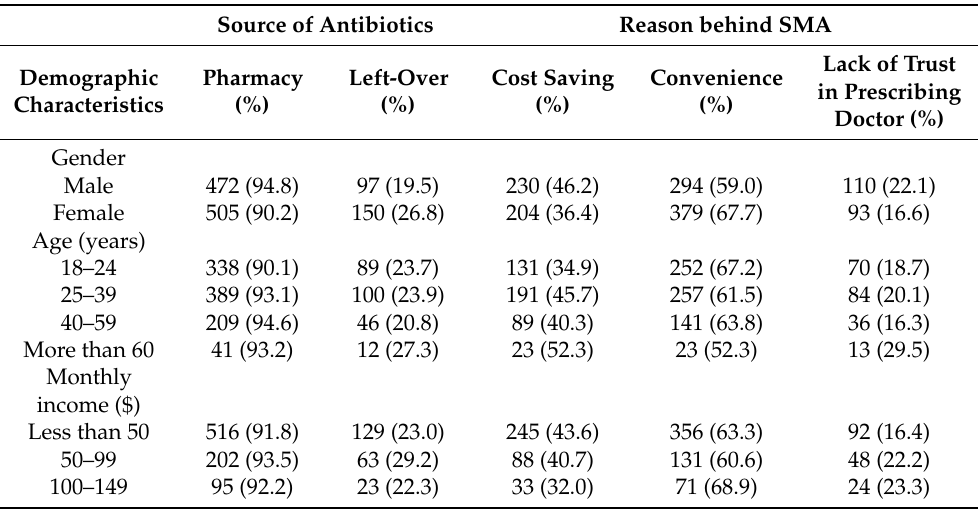
Table 2. Relation between demographical characteristic of the included participants and common sources and reasons behind